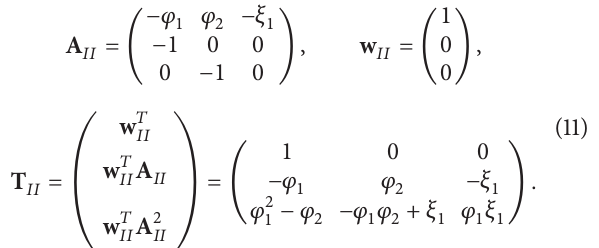
Analogically for the second equivalent system the matrix